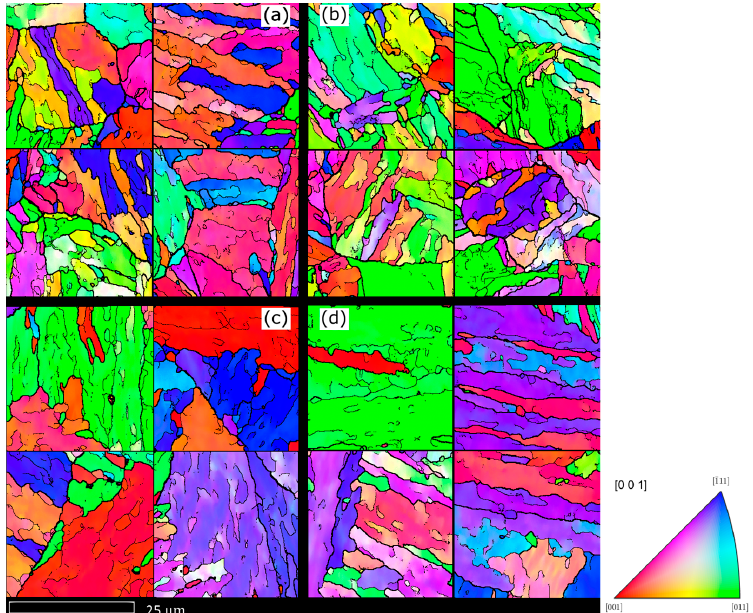
Figure 3. EBSD maps with IPFz colouring of the different microstructures. ( a ) HT3 19 mm bar; ( b ) HT5 19 mm bar; ( c ) HT3 50 mm bar; ( d ) HT5 50 mm bar. The single pixel black lines represent boundaries with misorientation between 2° and 15°, 2-pixel black line between 15° and 21° or more than 48°, and 3-pixel black linesbetween 21° and 48° to represent probable PAG boundaries. The maps are used to determine the lath sizes in Table 2.